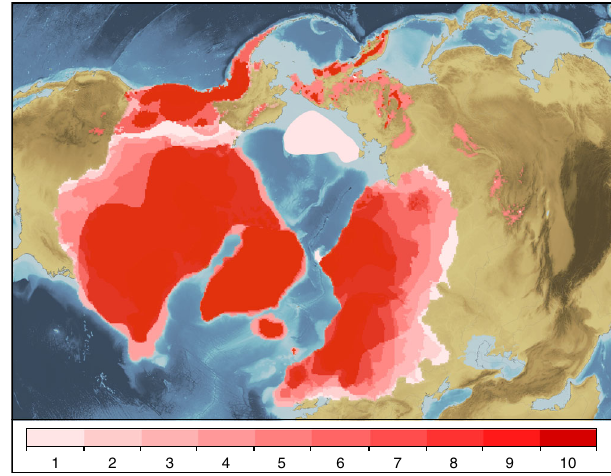
Fig. 4 Intensity map of the number of times that each region was covered by ice sheets, produced by overlaying the best-estimate ice-sheet reconstructions from MIS 2, 3, 4, 5, 6, 8, 10, 12, 16 and 20 – 24. Regions shaded dark red were subject to glaciation 8 – 10 times through the last 1 Ma. Ice-sheet reconstructions for the early Matuyama (Early Pleistocene) and late Gauss magnetic chrons (Late Pliocene) are omitted because of the broad time-spans and high uncertainty of these